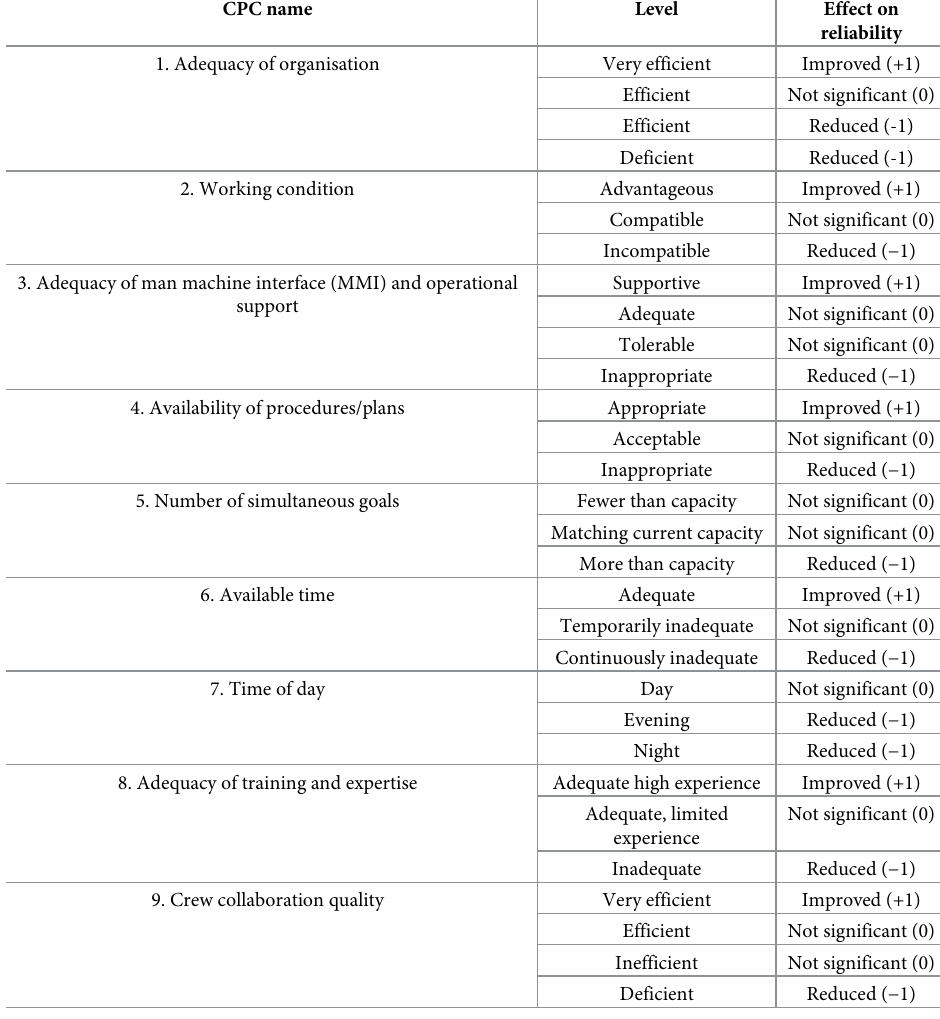
Table 1. CPCs and their effects on human